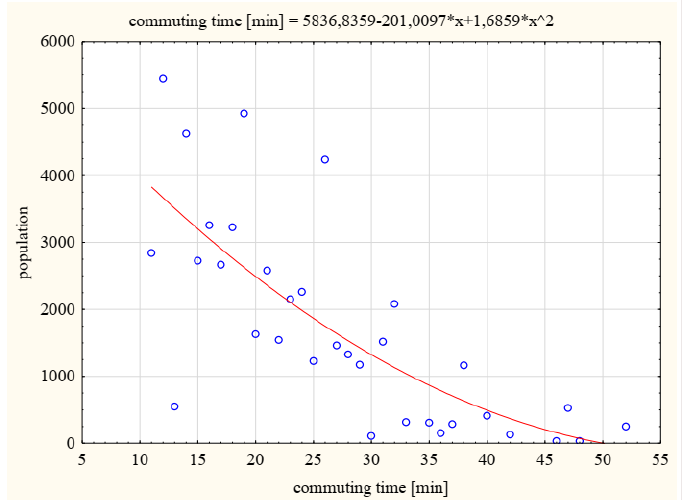
Figure 6. Relationship between population and commuting time in 2018. Source: own elaboration. Similar population trends were noted in cadastral districts. Relative population growth was highest in the vicinity of Olsztyn and in districts with the highest